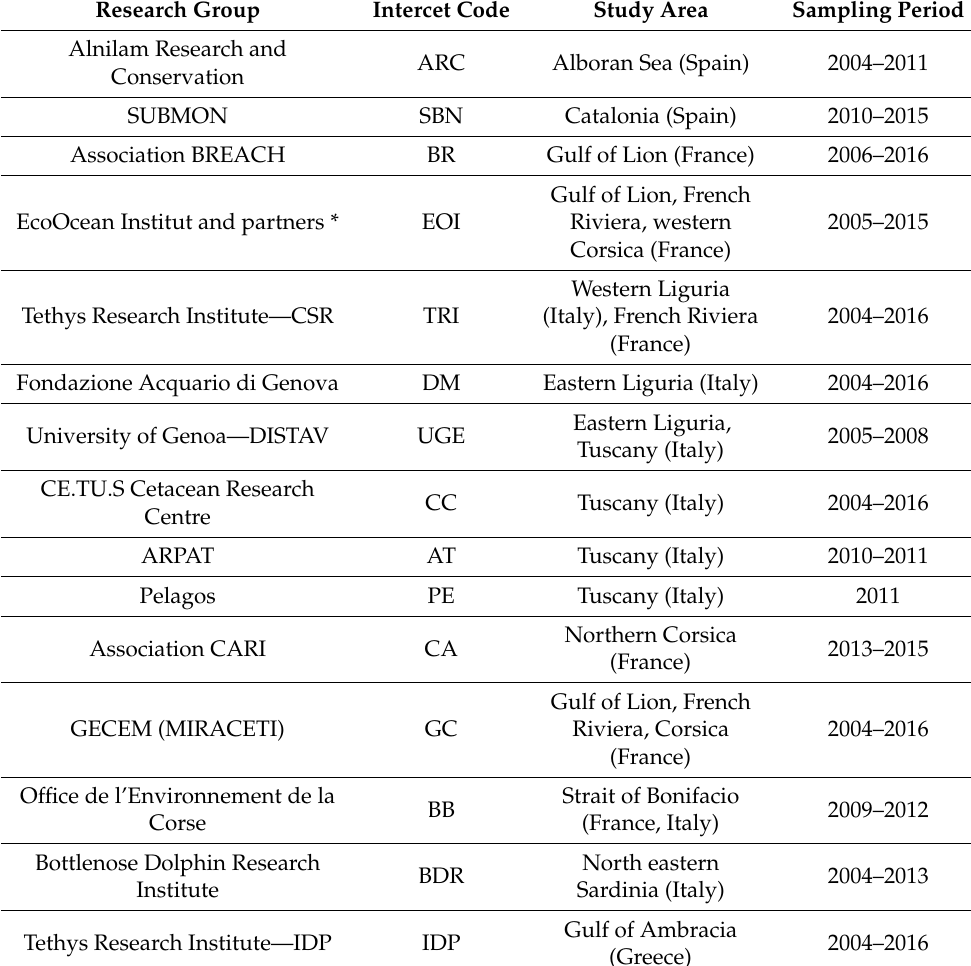
Table 1. Summary of information on the research groups involved in the